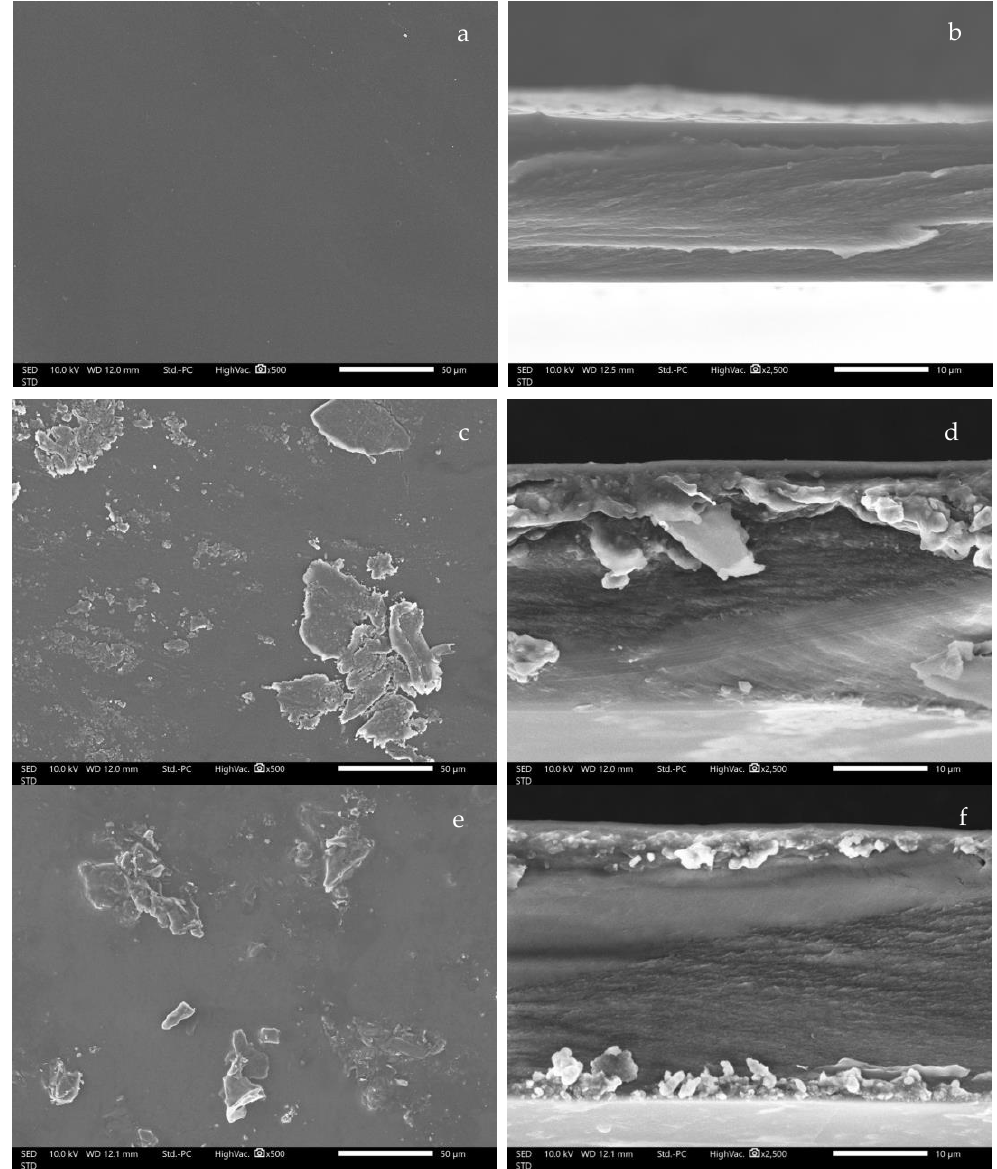
Figure 6. SEM micrographs of surface and cross-section of blank SCMC ( a , b ); SCMC-CM-powder ( c , d ); and SCMC-CM-nano films ( e , f ) at 500 and 2500 magnifications.